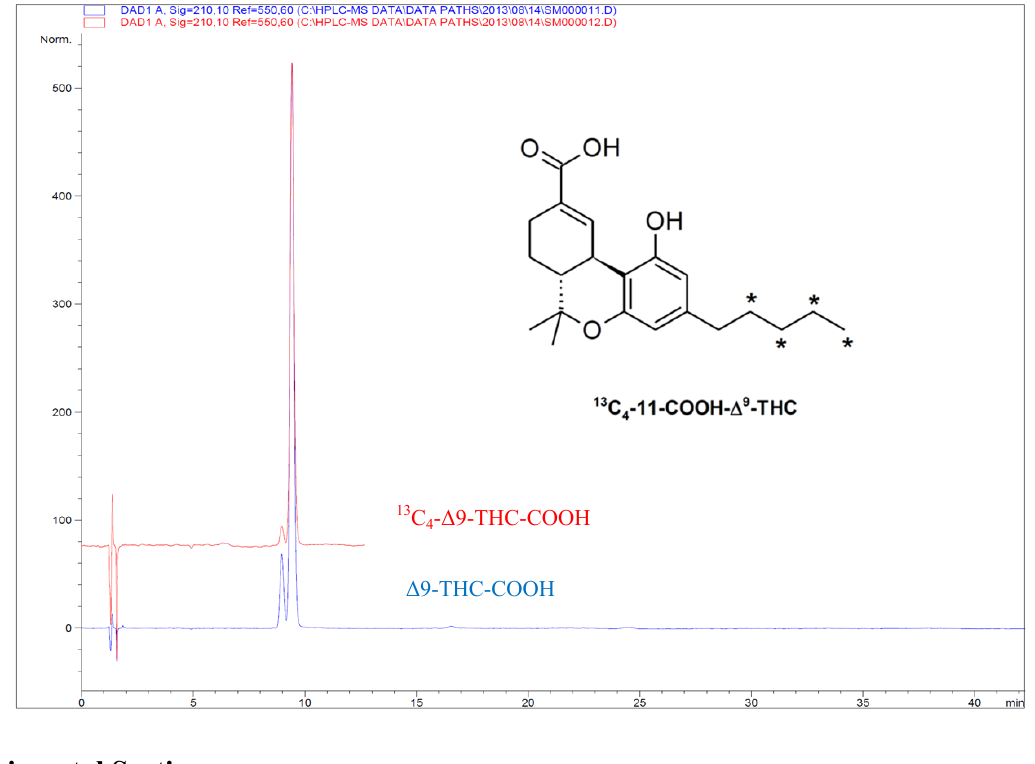
]-Δ 9 -THC-COOH ( 3 ) as compared to native Δ 9 -THC- 4 ]-Δ 8 -THC-COOH and Δ 8 -THC-COOH, 4